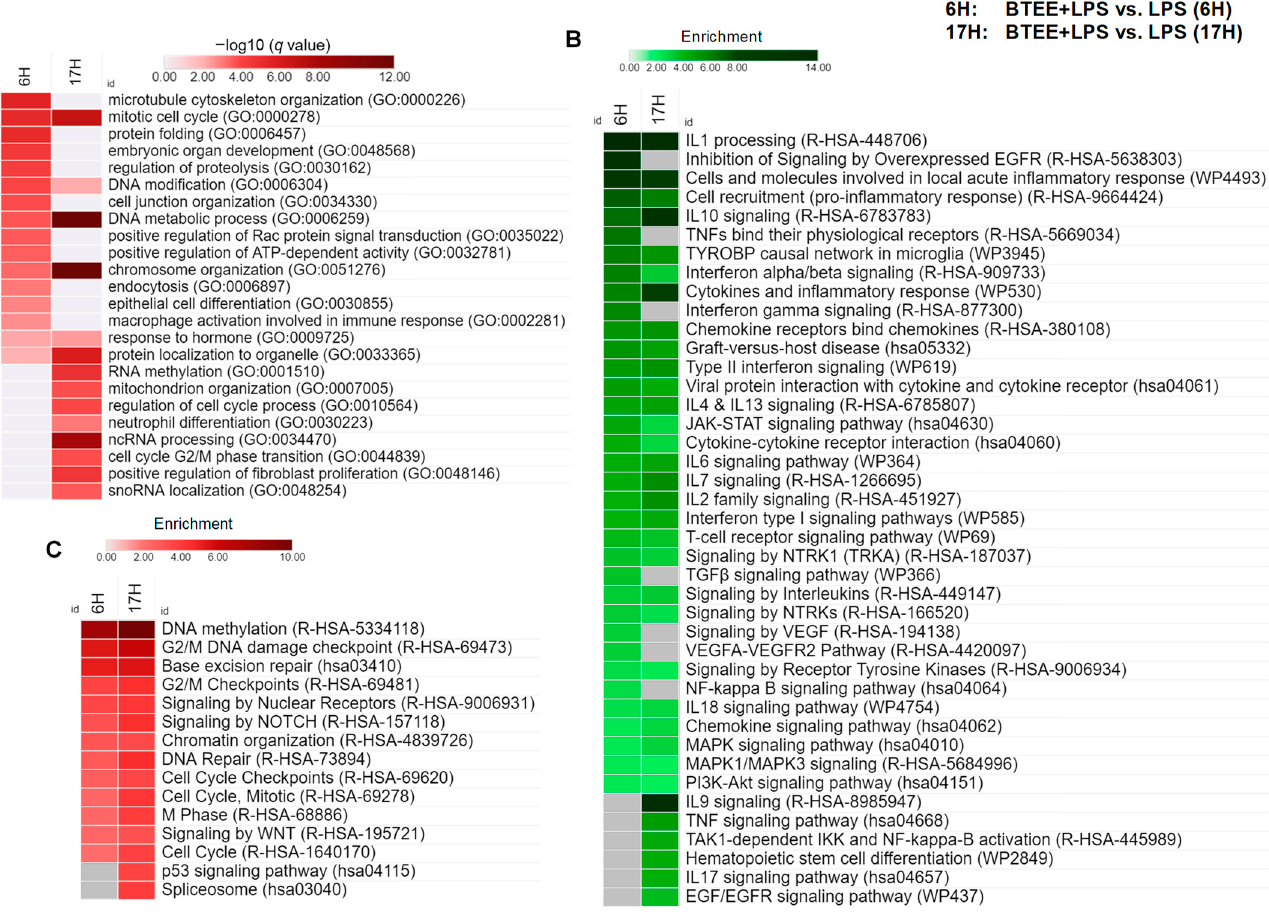
Figure 7. Biological process gene ontology (GOBP) and pathway enrichment analyses. ( A ) Heatmap shows significant GOBP terms in both 6-h and 17-h conditions enriched by the upregulated DEGs between BTEE-treated and nontreated RAW264 cells. Color code represents the − log10 q value (Benjamini–Hochberg adjusted p value for multiple comparisons). Significantly enriched pathways by the ( B ) downregulated and ( C ) upregulated DEGs. The color code represents the enrichment score.